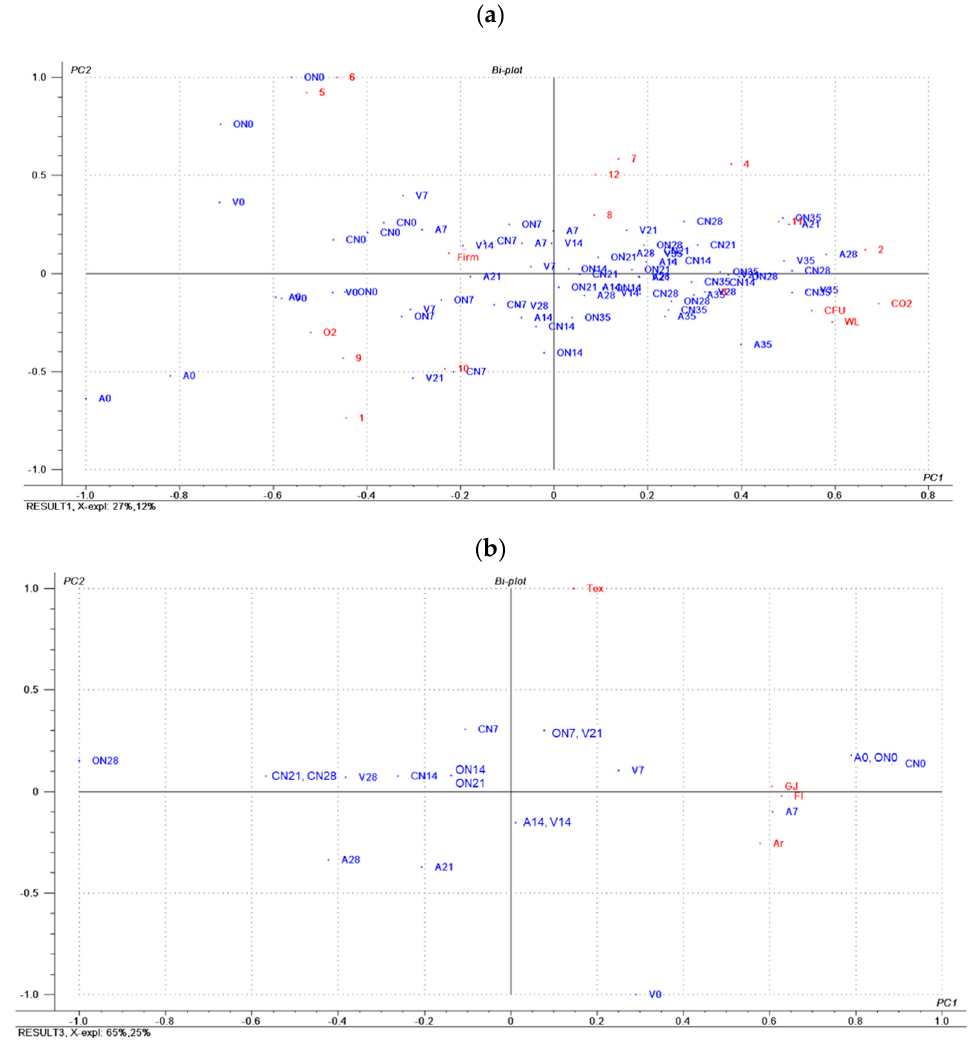
Figure 3. ( a ), Bi-plot of the principal component analysis (PC1 vs. PC2) performed using the normalized volatile compounds profile, physical, and microbial variables. A: atmospheric pressure, control; CN: 40% CO 2 / 60% N 2 ; ON: 1% O 2 / 99% N 2 ; V: hypobaric packaging at 30 kPa. 0, 7, 14, 28, and 35 days of storage. 1, hexanal; 2, ethyl methylbutanoate; 3, heptanal; 4, methoxybenzene; 5, 1-octen-3-ol; 6, 5-methyl-3-heptanone; 7, octanal; 8, 1-methoxy-3-methylbenzene; 9, 5-Ethylcyclopent-1-enecarboxaldehyde; 10, octenal; 11, 2-nonen-1-ol; 12, 1,2-dimethoxybenzene. FIRM, instrumental penetrometric determination (g); O 2 and CO 2 , oxygen and CO 2 measured % of the head space. ( b ), PCA Bi-plot of the mean sensory scores (PC1 vs. PC2) across the samples. Tex = texture; GJ = global judgement; Fl = flavor; Ar = aroma.